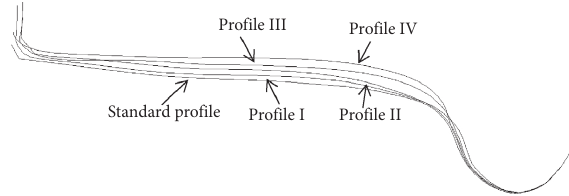
Figure 2: Wheel profiles at different abrasion